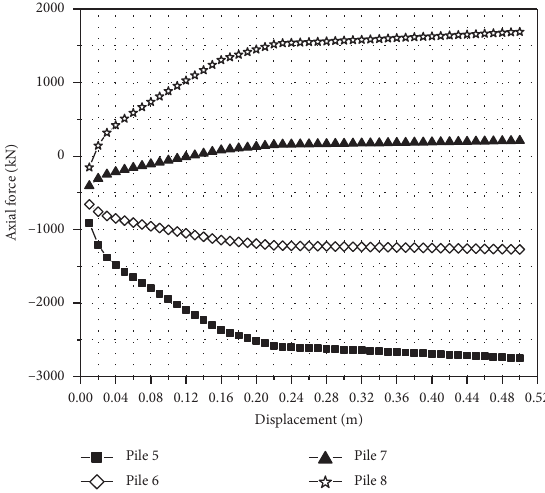
Figure 38: Axial force-displacement at the top of piles